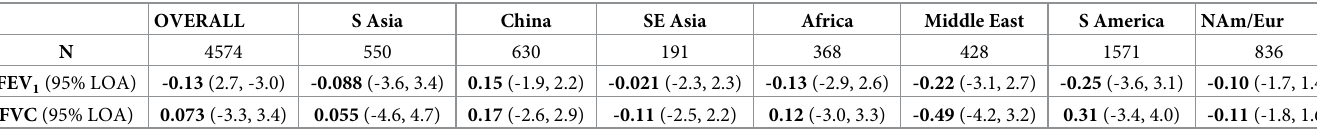
FEV 1 = forced expiratory volume in the first second measured; FVC = forced vital capacity; LOA = 95% limits of agreement; z-scores were estimated using the Global Lung Function Initiative normative values appropriate for age, sex, height and ethnicity. Mean differences and LOA provided were calculated using Bland-Altman